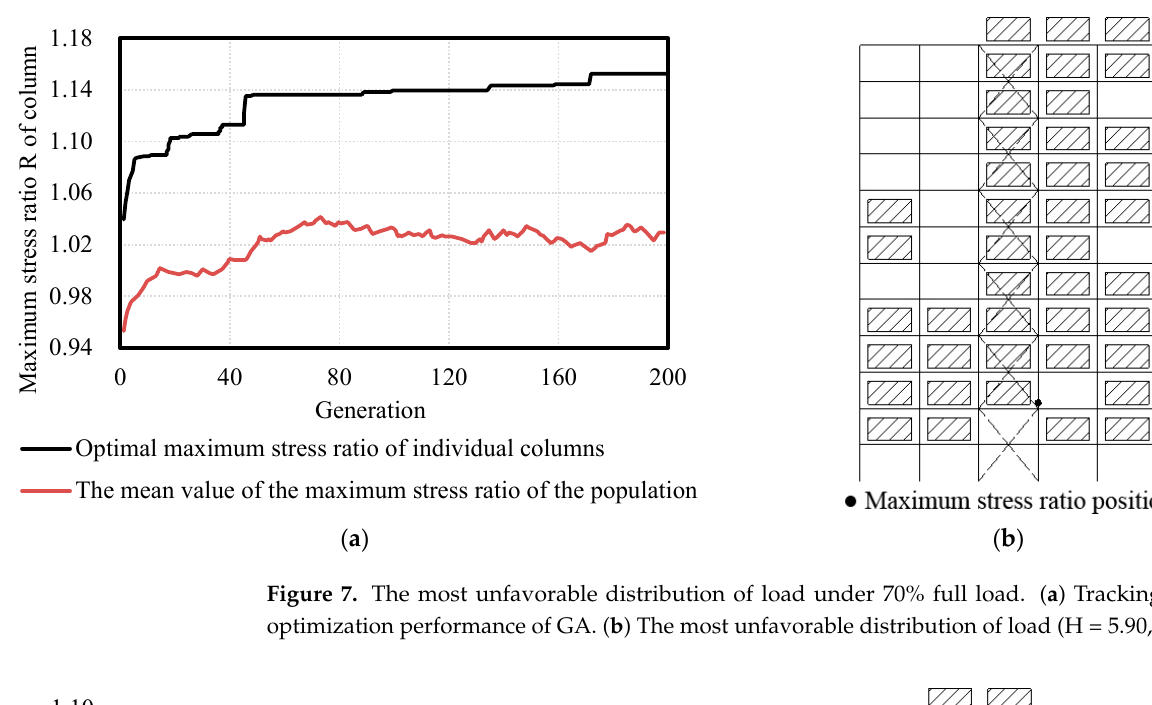
Figure 6. The most unfavorable distribution of load under 80% full load. ( a ) Tracking chart of optimization performance of GA. ( b ) The most unfavorable distribution of load (H = 6.00, P = 0.29).